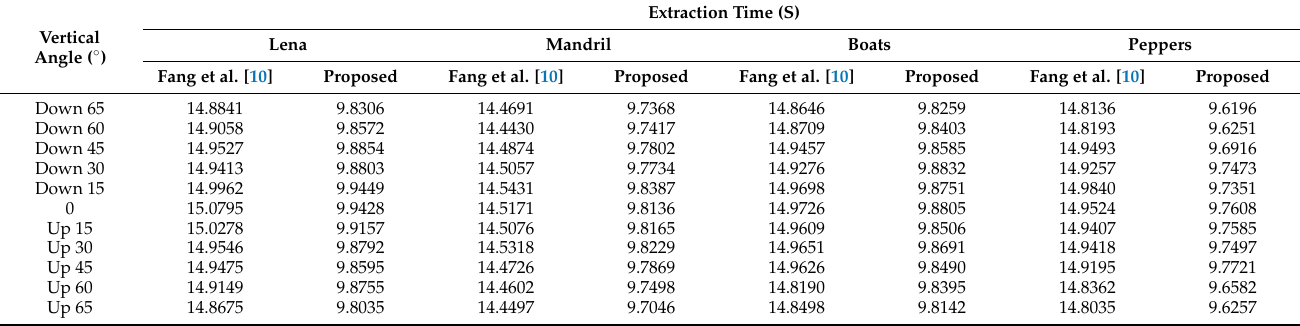
Table 12. Watermark extraction time at different vertical